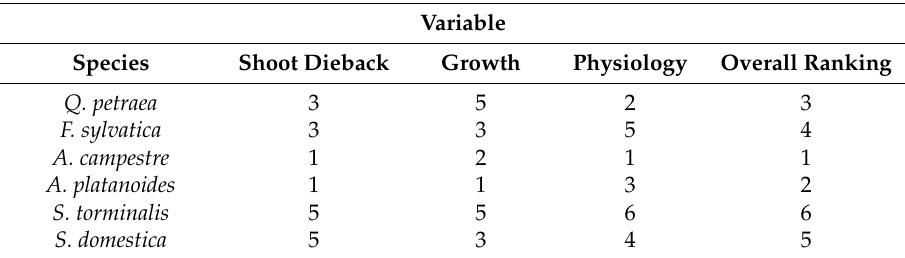
Table 6. Relative ranking of the tree species according to their drought tolerance based on the variables shoot dieback, resistance to drought stress in relation to biomass growth (defined as relative biomass growth of seedlings within the dry group), and physiological performance under severe drought stress (physiology; defined as the integral of the A max to g s curve; Figure 4). The variables were ordered according to their relevance to express drought tolerance, the ranking of species’ drought tolerance in relation to each variable was from 1 (most drought tolerant) to 6 (least drought tolerant). When no significant differences between the species were detectable, the same numbers were assigned. Variable Shoot Dieback Growth